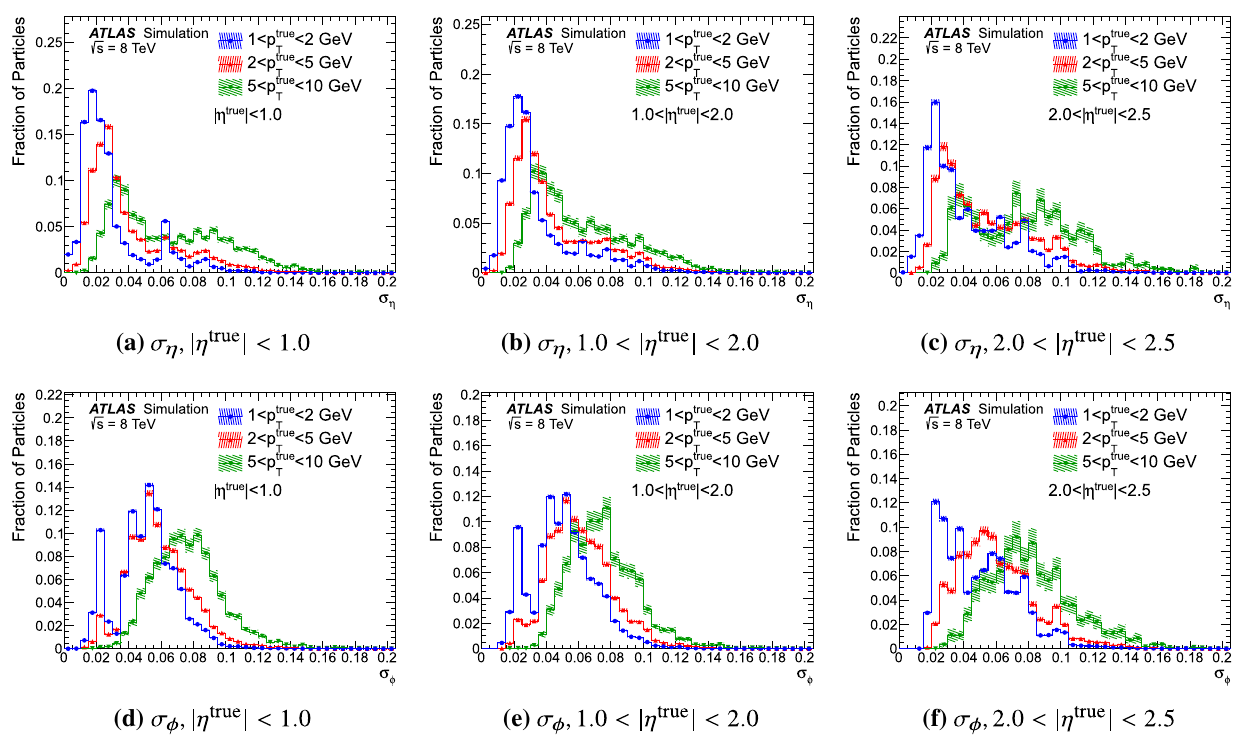
Fig. 10 The distribution of σ η and σ φ , for charged pions, in three dif- ferent regions of the detector for three particle p T ranges. The data are taken from a dijet sample without pile-up with 20 < p lead